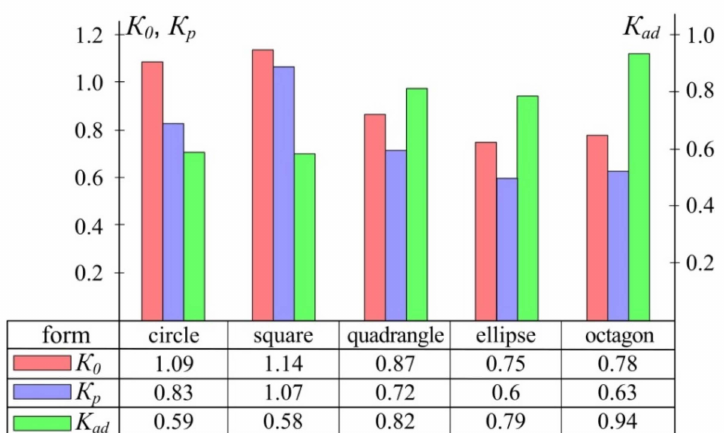
Figure 8. Effect of the patch shape on the degree of loading of the repaired panel ( K 0 ), patch ( K p ) and adhesive interlayer between them ( K ad ).